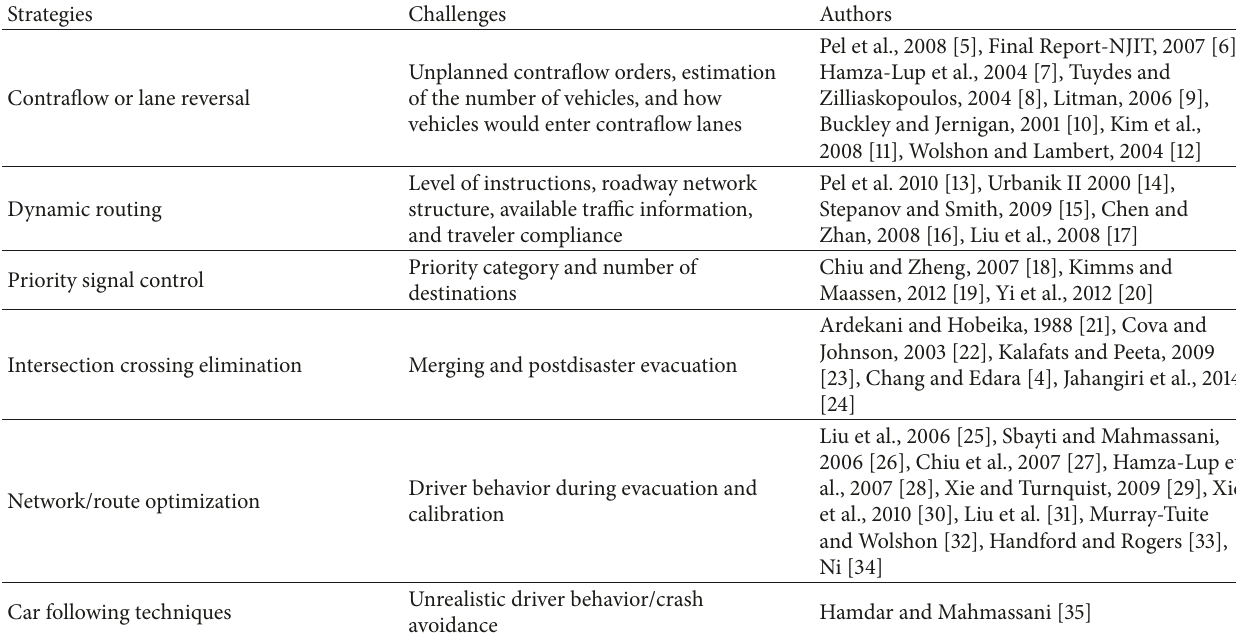
Table 1: Review of previous strategies to reduce evacuation